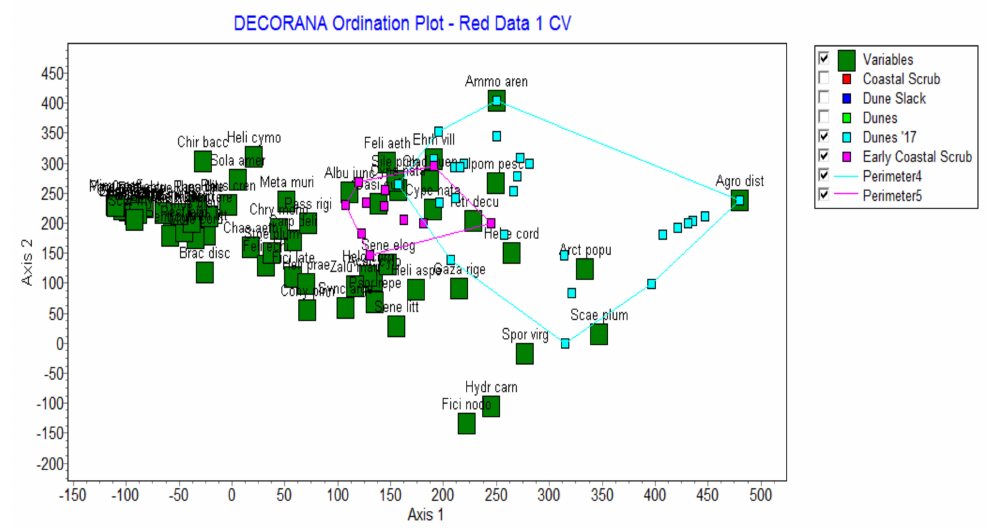
Figure 3. Scatter plot of all the 64 species of the coastal dunes in the Eastern Cape sites on the first two axes produced by Detrended Correspondence Analysis. See Table 3 for species names listed in